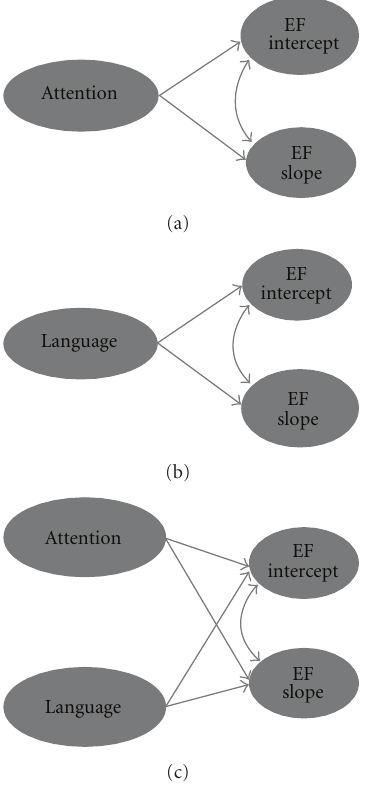
Figure 2: Three simplified models showing executive function (EF) development. Model (a) includes a latent construct of attention that influences baseline levels (EF intercept) and rate of growth of EF (EF slope). Model (b) shows a latent construct of language mediating baseline EF and its developmental trajectory. Model (c) includes latent constructs of attention and language, which both influence the development of EF. These models could be tested using latent growth curve